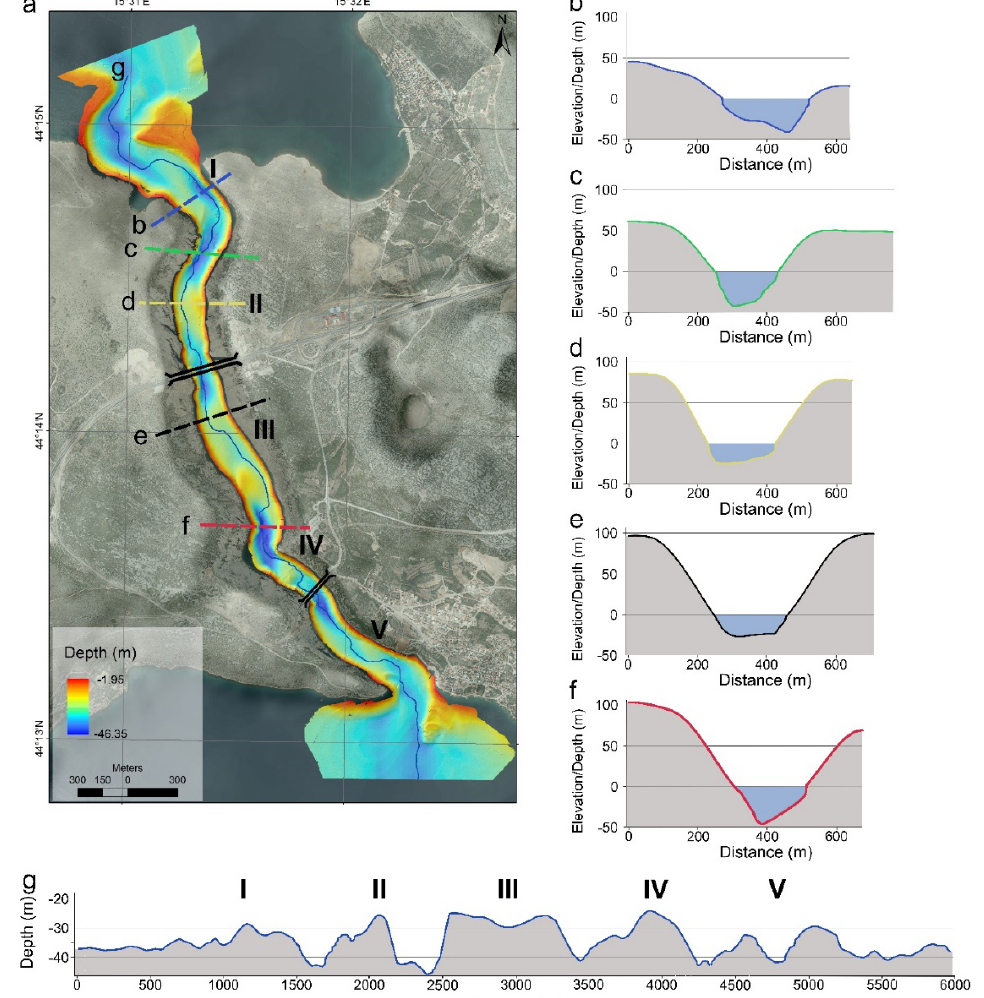
Figure 2. ( a ) Bathymetry image of NZD draped over the DTM and the orthophoto image [27]. Prominent barriers are marked with numbers I–V. ( b – f ) Profiles showing the barriers and deepest parts of the NZD canyon with steep and high sides with depths of over 45 m and elevations of up to 150 m a.s.l. ( g ) The lowest profile through NZD showing a possible path of the water flow (out of and into the Novigrad Sea) during the lowstand and sea-level rise. The same barriers from ( a ) are marked with numbers I–V. The two bridges across NZD are illustrated as